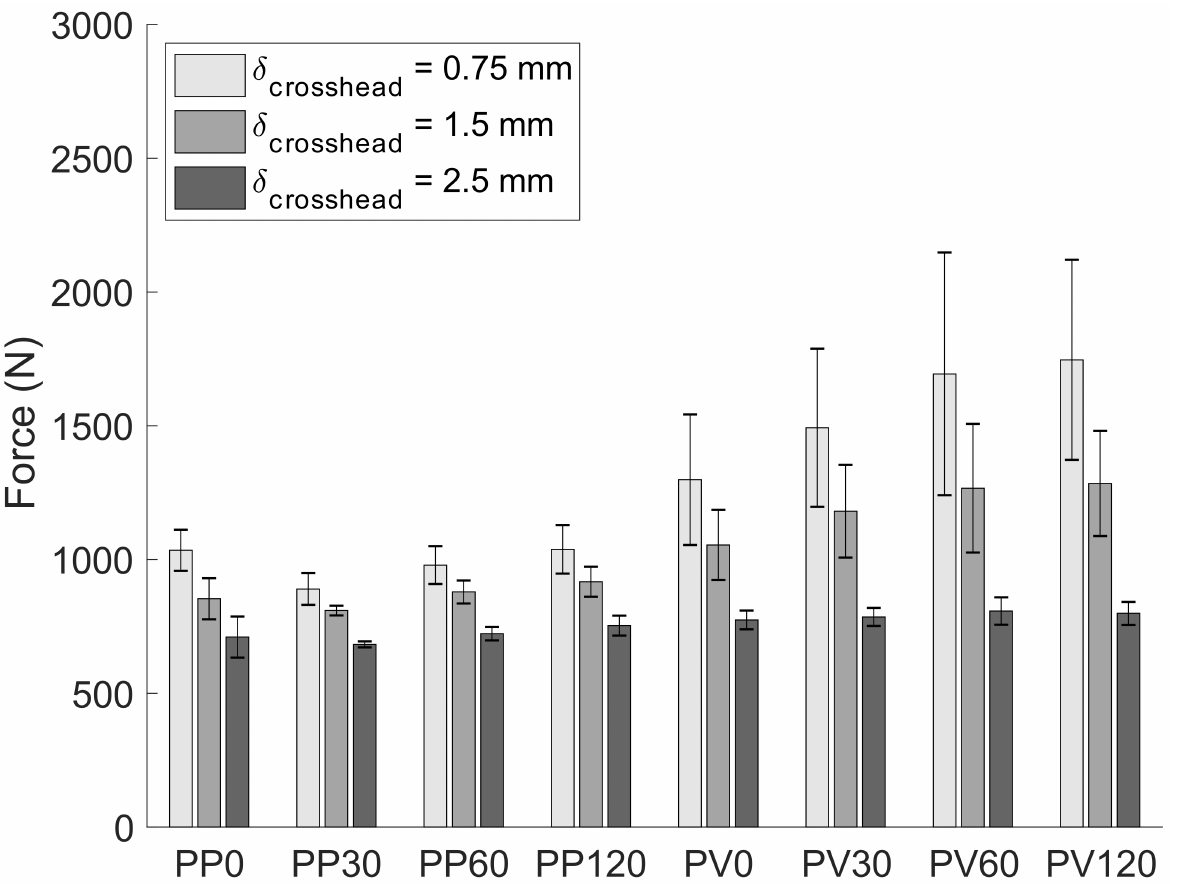
Figure 9. Residual load capacity at various displacements for flexural fiber